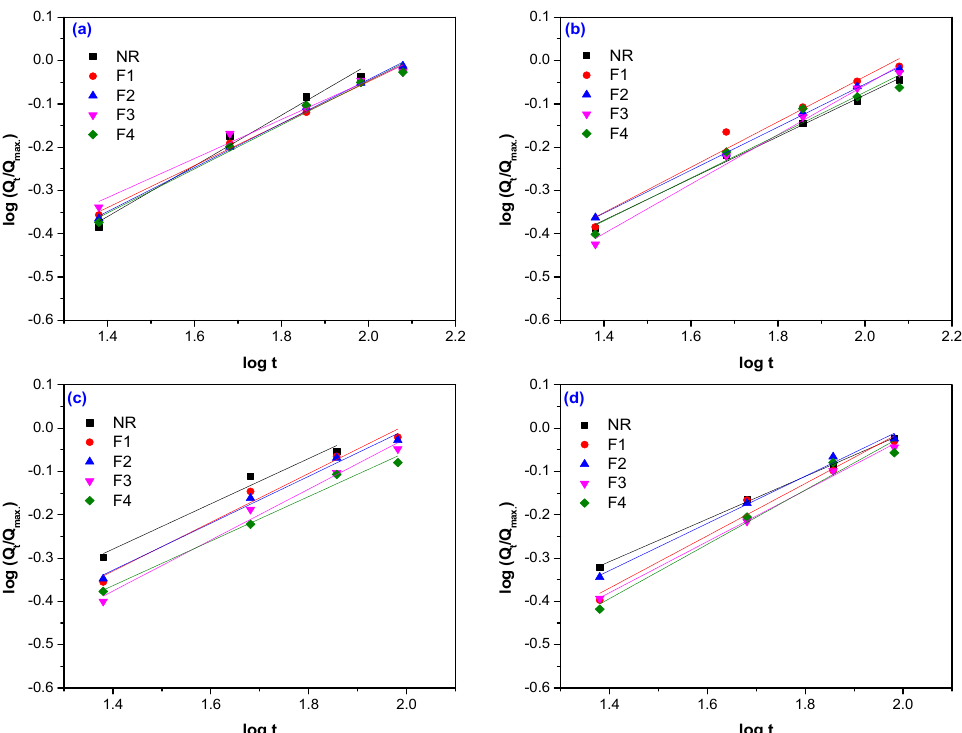
Figure 6. Determination of the diffusion parameters n and k for NR samples reinforced with flax and vulcanized by EB irradiation at 75 kGy ( a ), 150 kGy ( b ), 300 kGy ( c ) , and 600 kGy ( d ).